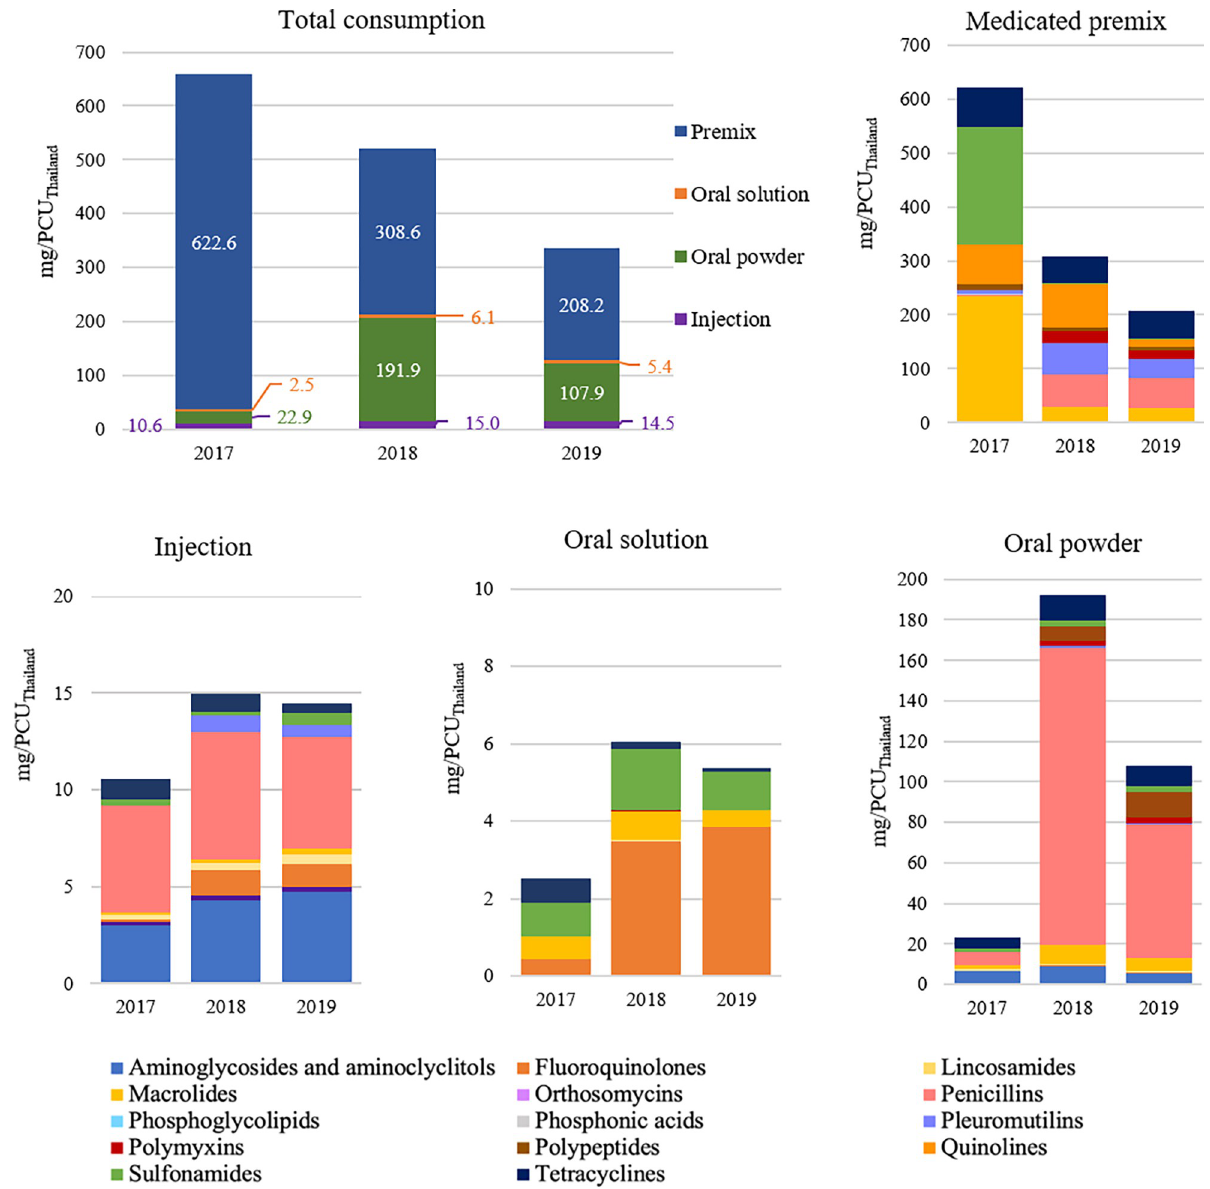
Fig 2. Trends of antimicrobial consumption in food-producing animals by route of administration (2017–2019), total consumption and premix (upper panel), and injection, oral solution and oral power (lower panel) (mg/PCU Thailand ). Note: Does not include antimicrobials that had less than 1 tonne of consumption (intramammary and other